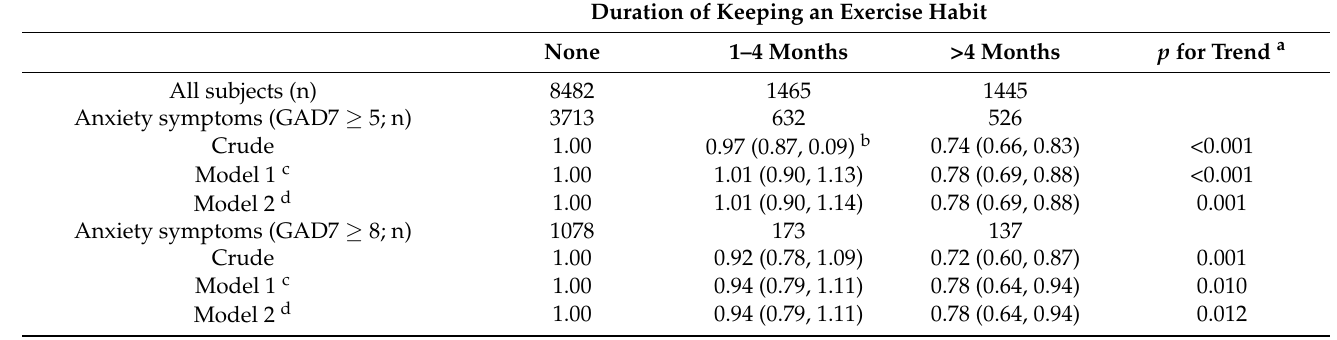
Table 3. Adjusted association for anxiety symptoms according to categories of duration of keeping an exercise